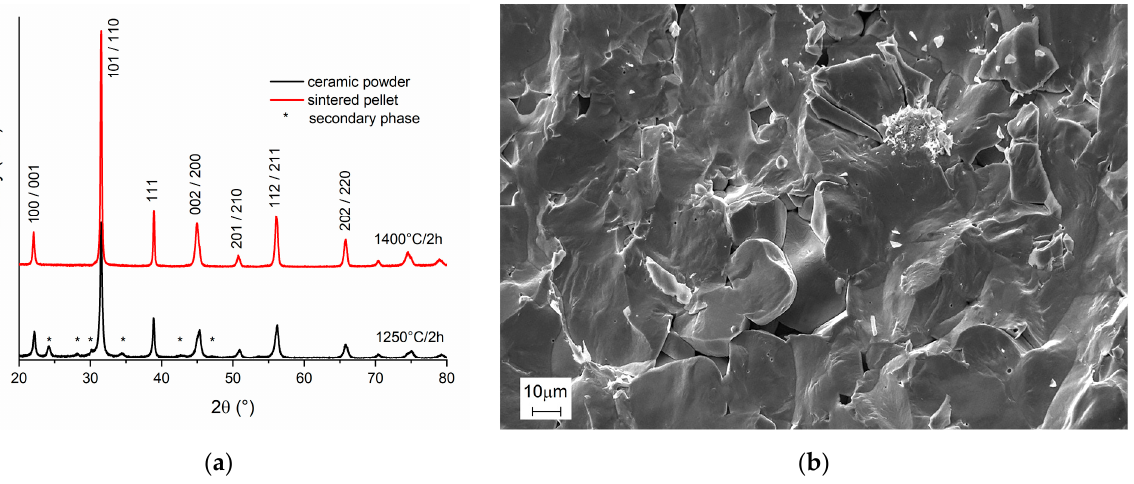
Figure 1. ( a ) XRD patterns of BCTZ8-5 powder and sintered ceramic obtained by conventional solid-state reaction. ( b ) SEM micrograph of the fracture surface of the sintered